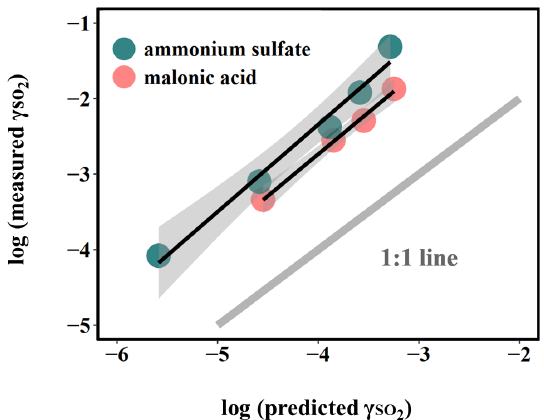
Figure 4. Relationship between measured γ SO predicted and γ SO 2 2 by Eq. (5). The large deviation from the 1 : 1 line, which repre- sents the difference between the measured uptake coefficient and predicted values based on kinetics in the dilute aqueous phase, in- dicates that aerosol reactive uptake is significantly faster than reac- tions in the dilute aqueous phase. This enhancement is likely driven in part by high ionic strengths, as the difference between mea- sured γ SO and predicted γ SO is consistently higher for organic- 2 2 peroxide-containing ammonium sulfate (high ionic strength) than for that mixed with malonic acid (lower ionic